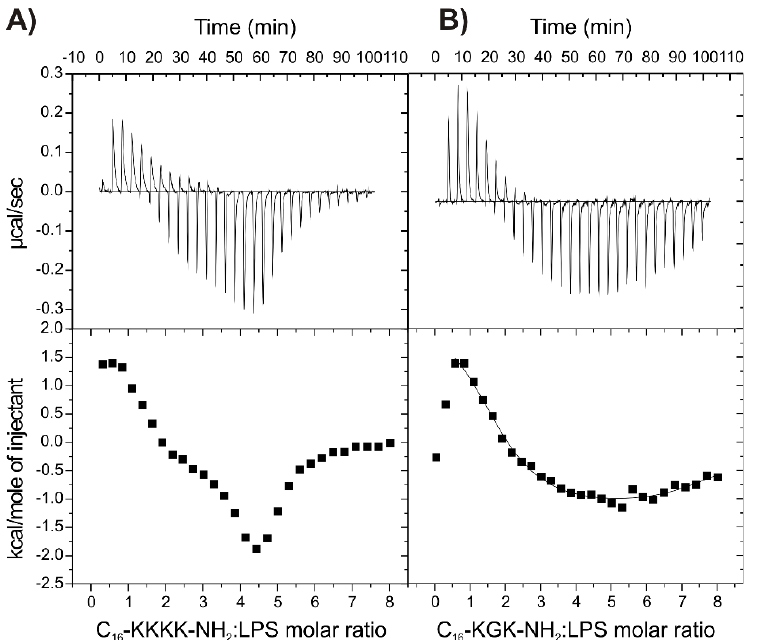
Figure 4. Isothermal titration calorimetry (ITC) traces showing heat changes upon titration of the 0.5 mM C 16 -KKKK-NH2 ( A ) and 0.75 mM C 16 -KGK-NH2 ( B ) to 0.02 mM (400 µg/mL) LPS E. coli 055:B5. The bottom curves represent the heat of reaction vs. lipopeptide/LPS molar ratio.